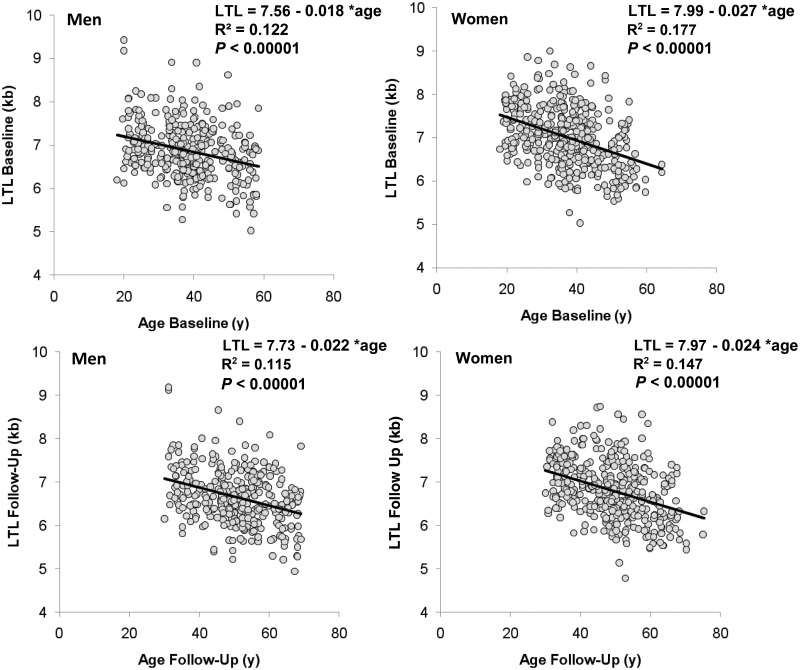
Leukocyte telomere length vs age in men and women; y, years. Data of baseline examination are presented in the upper panels and data of the follow-up examination are presented in the lower panels. Parameters of the linear regressions are displayed in each of the panels (from model including twin identity as random effect; R2 in the graphs refer to increase in R2 due to the age effect, given the twin identity effect).